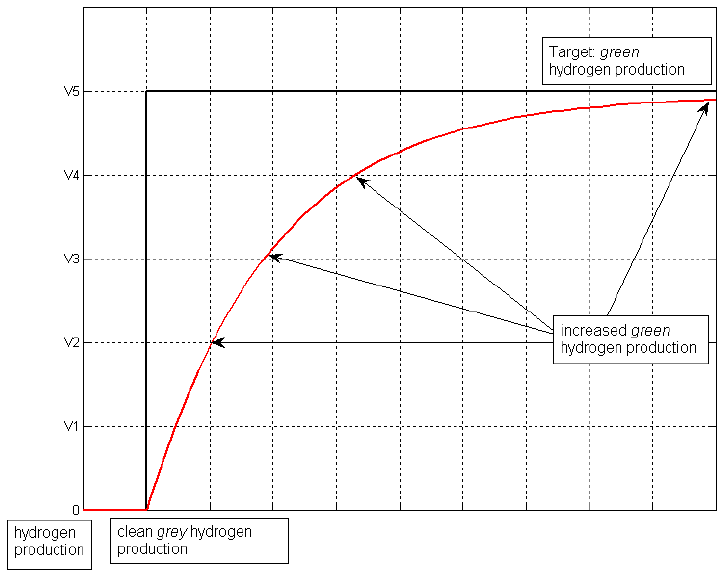
Figure 1. The way to variant V5: production of 100% pure and green hydrogen—own study.